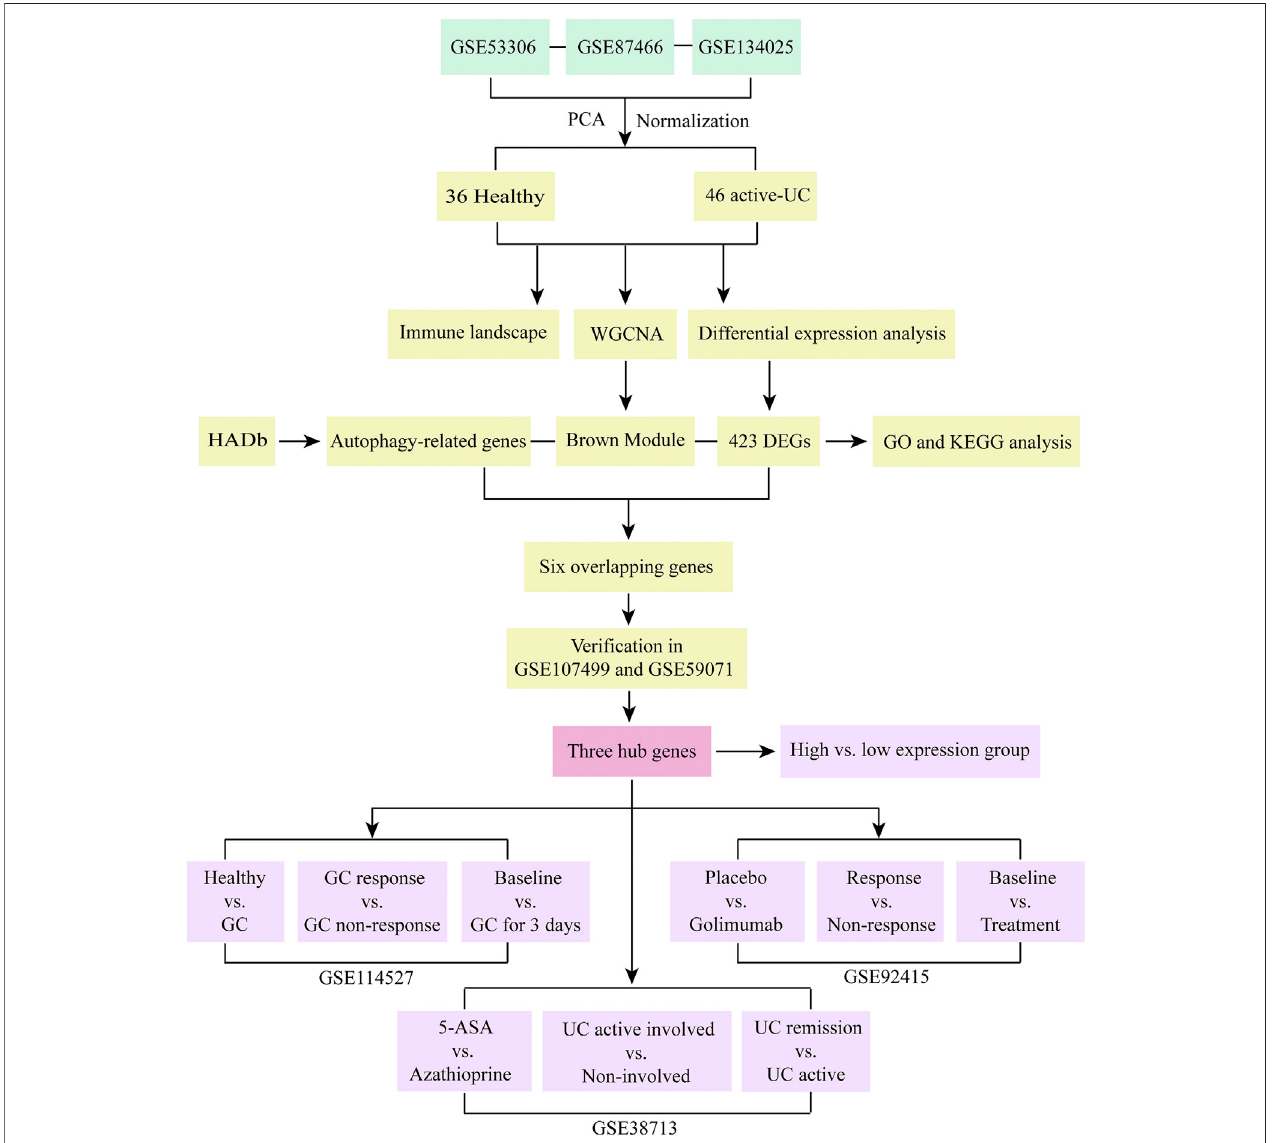
FIGURE 1 | Research fl ow chart of this study. PCA, principal component analysis. UC, ulcerative colitis. WGCNA, weighted gene co-expression network analysis. HADb, the Human Autophagy Database. DEGs, differentially expressed genes. GO, the Gene Ontology. KEGG, the Kyoto Encyclopedia of Genes and Genomes analyses. GC, glucocorticoid. 5-ASA, 5-aminosalicylic acid.